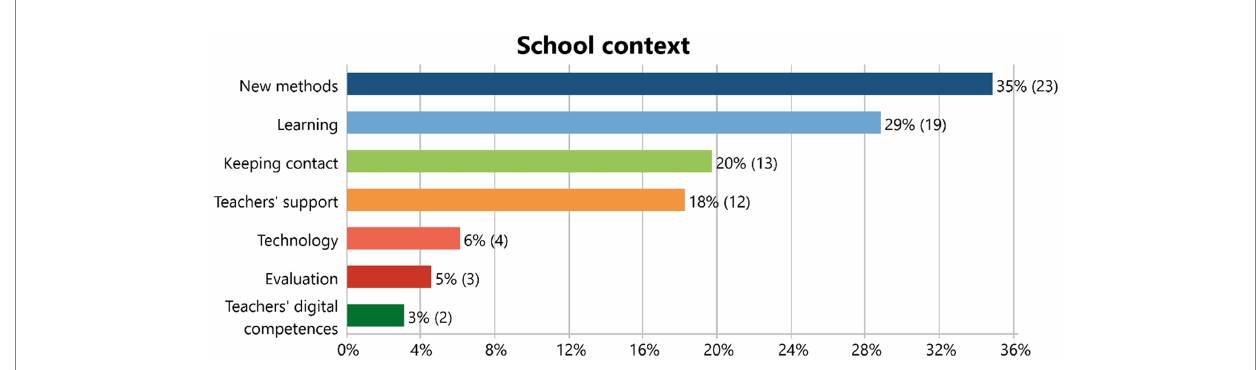
FIGURE 10 Frequency of documents referring to the subcategory School Context, within the category Potential and